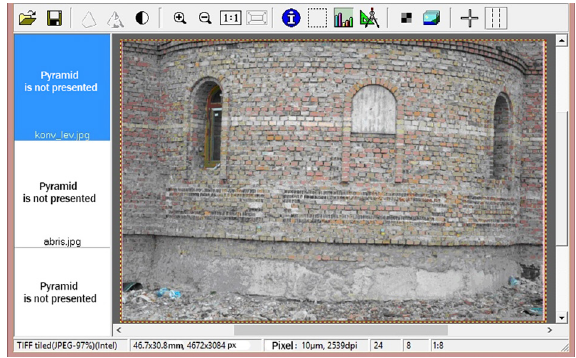
Figure 7. The main interface of the module DіpEdіt After opening, we saved all images in the “TIF tiled” format using the “File/Save All As” command in the pro- gram menu. The “Create Pyramid” function allows the program to create images of different resolutions (8 lev- els) for each one, which speeds up the process of scaling images. Table 3. Accuracy of normal and convergent survey methods (inclination angle α), with equal other